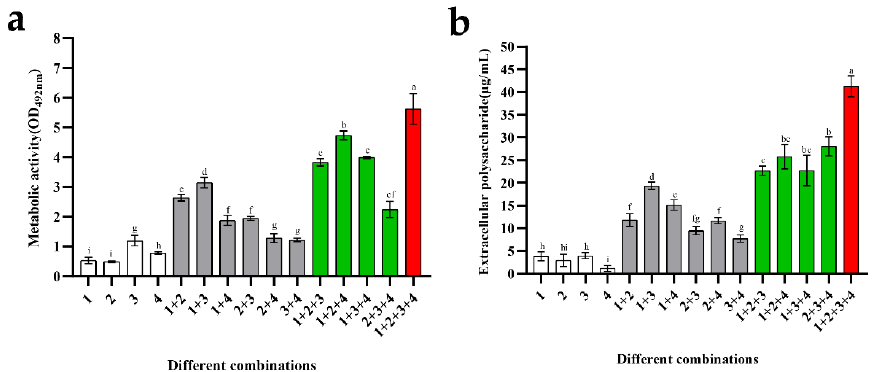
Figure 5. Metabolic activity and exopolysaccharide concentration of mono ‐ and mixed ‐ species bio ‐